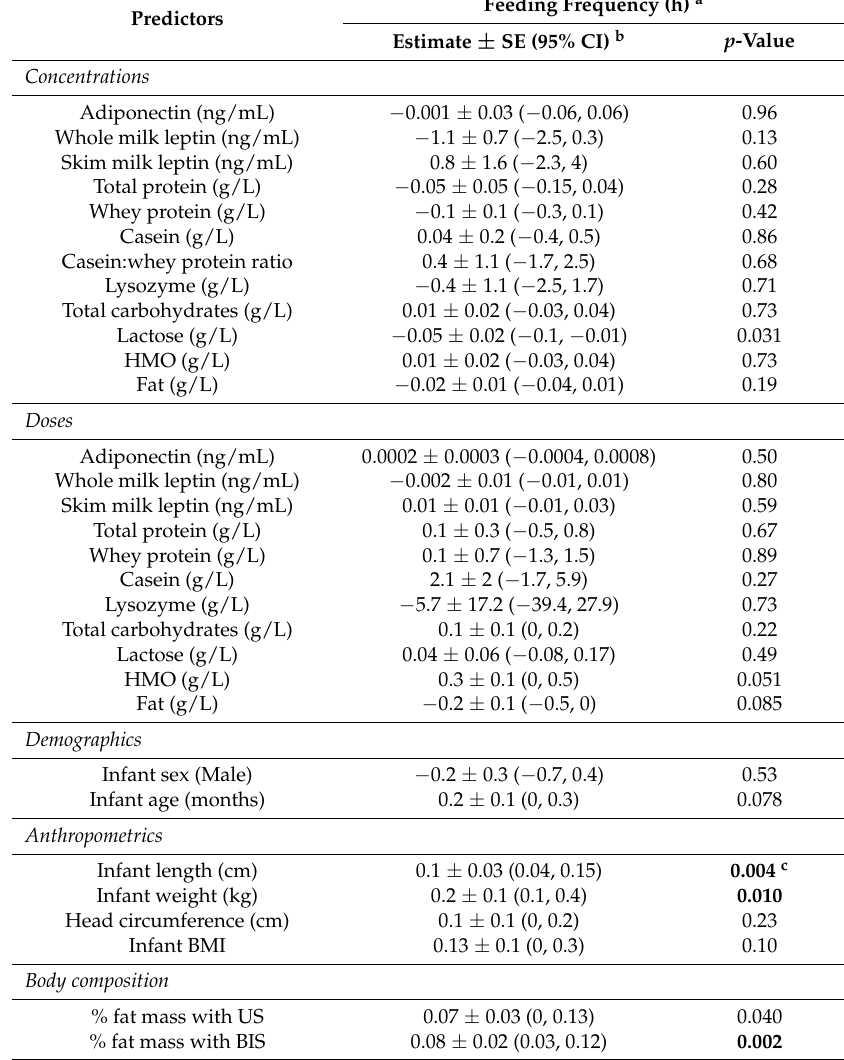
Table 4. Associations between infant feeding frequency and HM components and infant